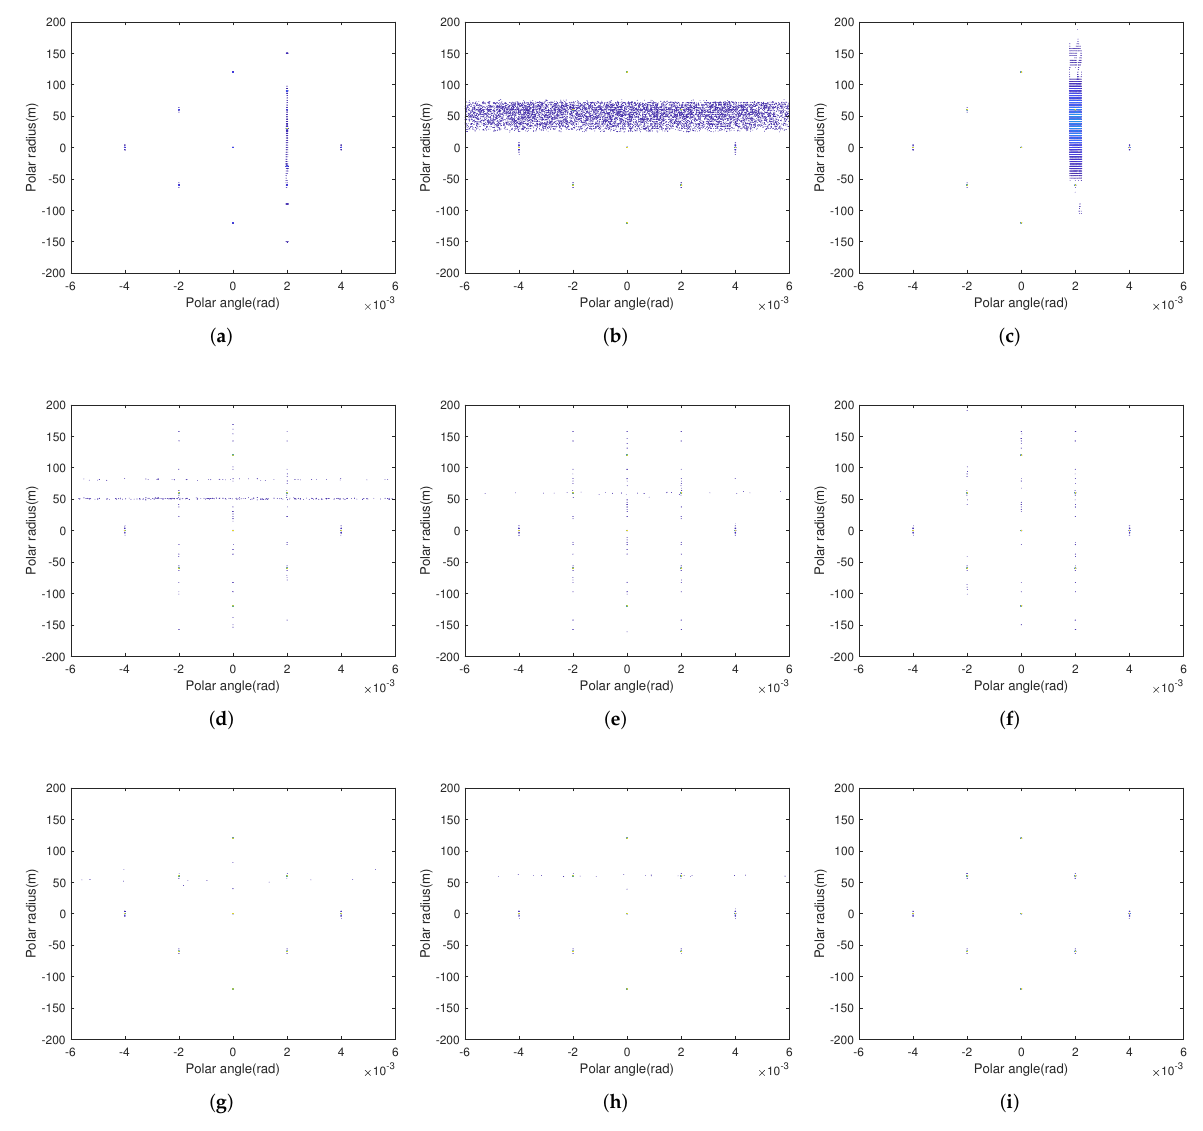
Figure 12. Image scene composed of 9 points: ( a ) RSF-LS-DFC SAR with FFSI; ( b ) RSF-LS-DFC SAR with RFSI; ( c ) RSF-LS-DFC SAR with SFSI; ( d ) RSF-IC-DFC SAR with FFSI; ( e ) RSF-IC-DFC SAR with RFSI; ( f ) RSF-IC-DFC SAR with SFSI; ( g ) RSF-DC-DFC SAR with FFSI; ( h ) RSF-DC-DFC SAR with RFSI; ( i ) RSF-DC-DFC SAR with